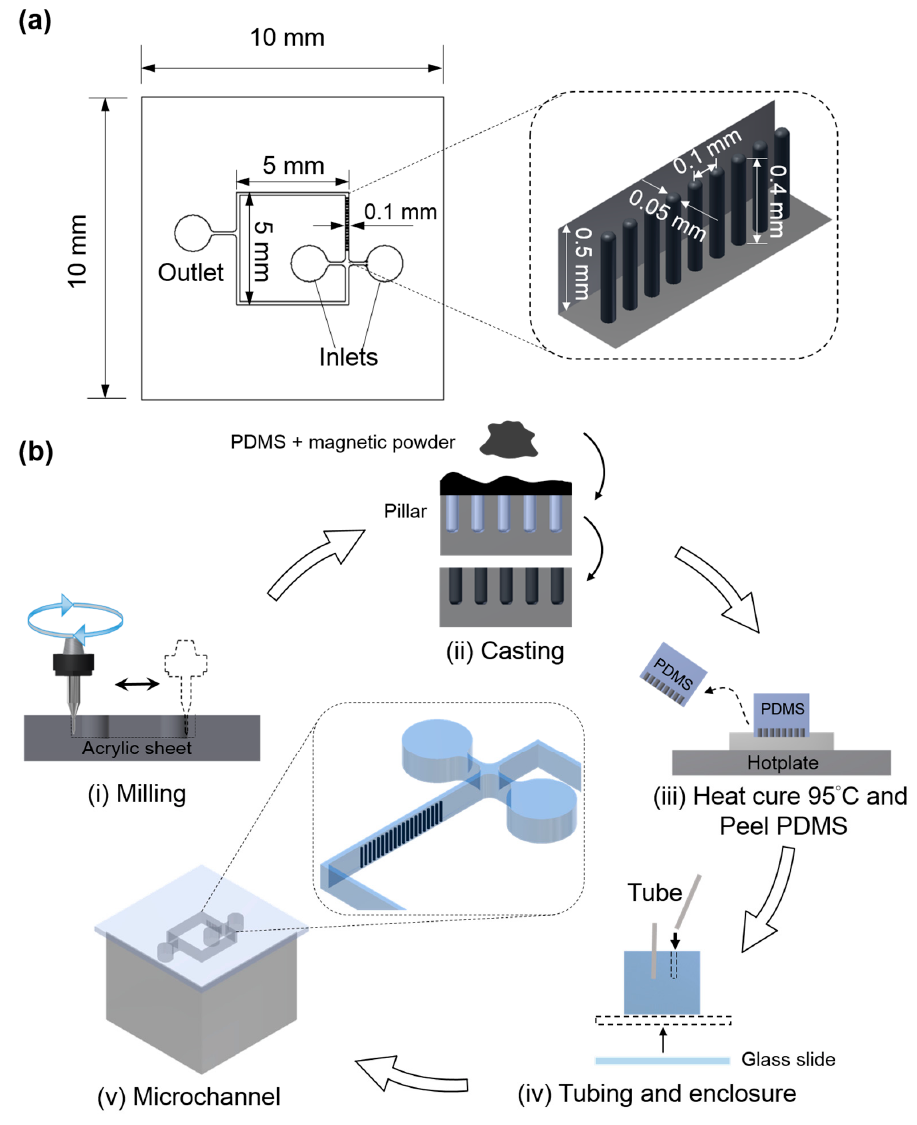
Figure 1. ( a ) Design and dimensional details of the microchannel (inset picture illustrates the dimensional details of artificial cilia); ( b ) Microfabrication flow process